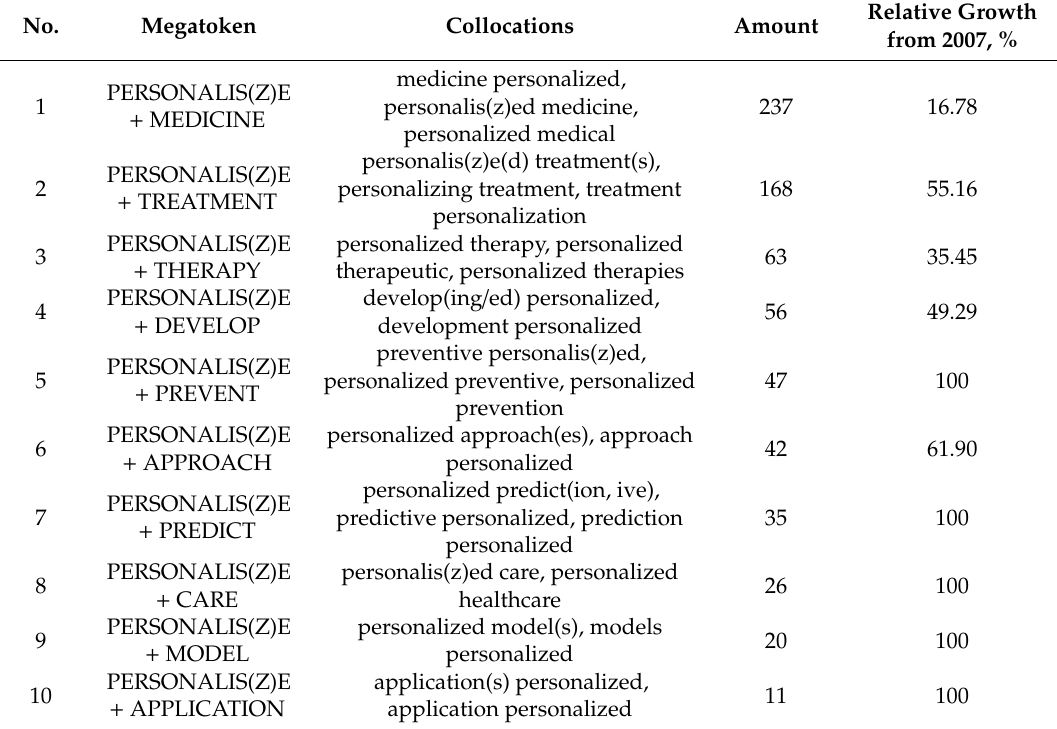
Table 4. Significant collocations with derivatives having “personalis(z)e” as the root word extracted from the PubMed database for the period from 2007 to 2019 (blue color in